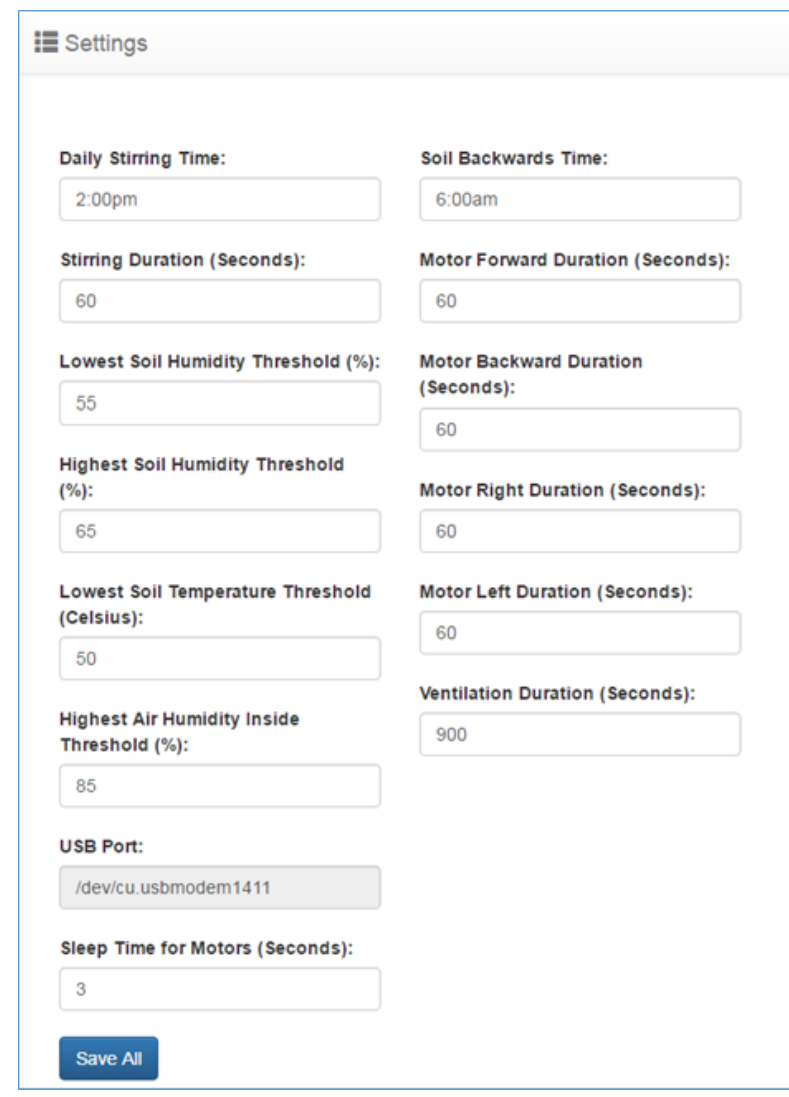
Figure 11. System